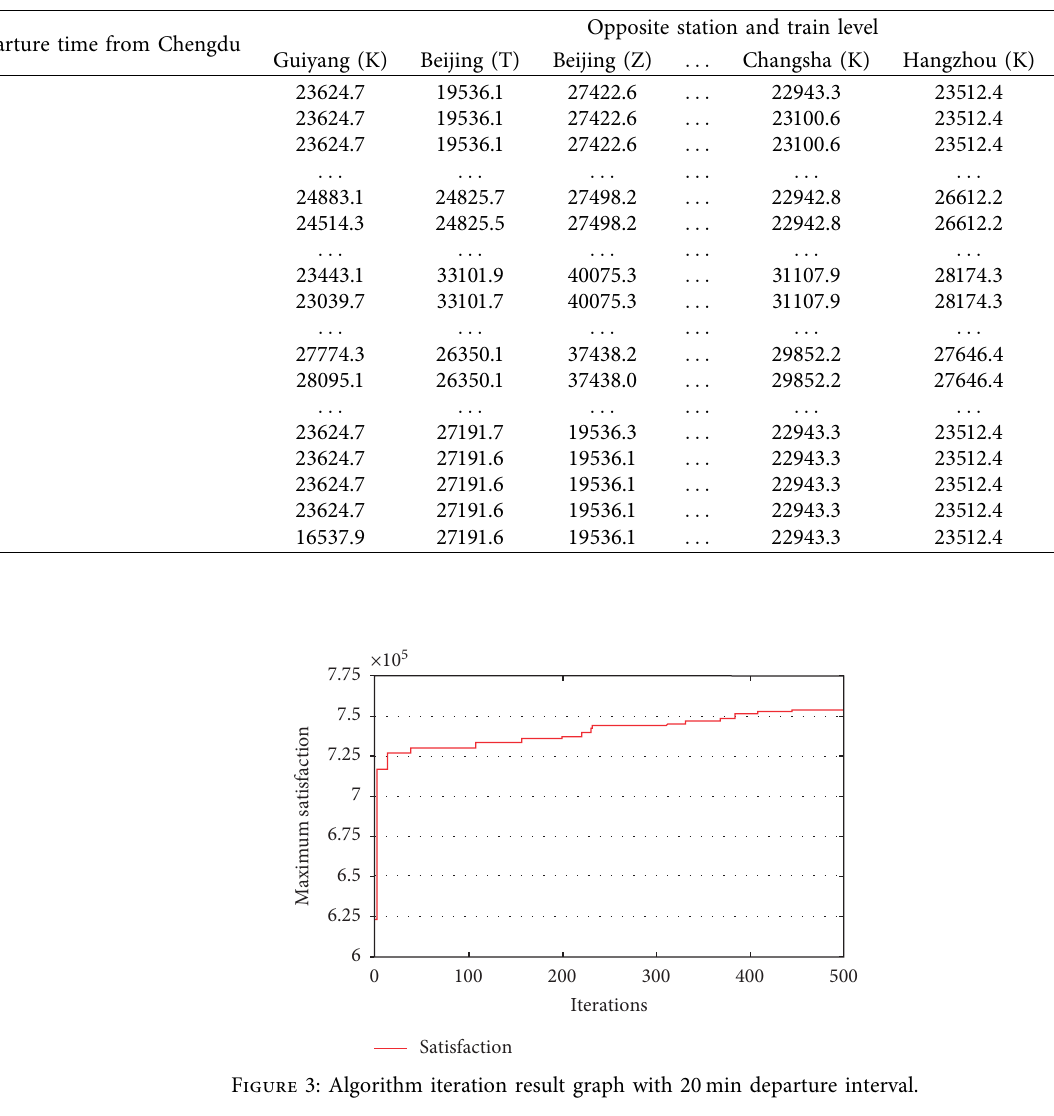
Table 3: Overall satisfaction of 23 pairs of passenger trains departure at each time.